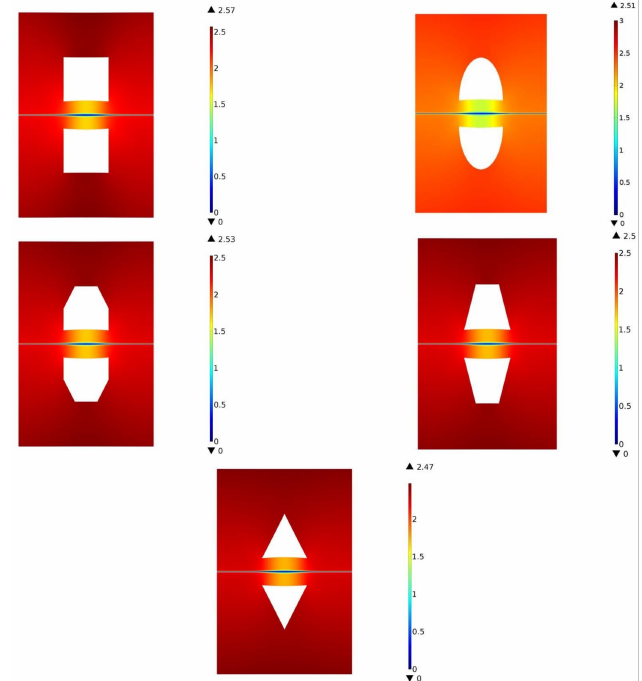
Figure 7. The displacement ( µ m) in the PEM-FC through the process of assembly at height = 1 mm, with scale increased 50